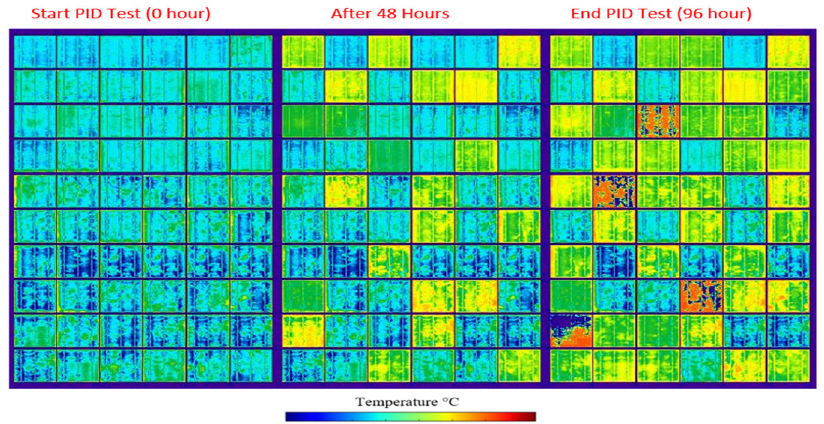
Fig. 7 Thermal images for one of the examined PV modules taken under standard test conditions. The EL image of this PV module is shown in Fig. 2.